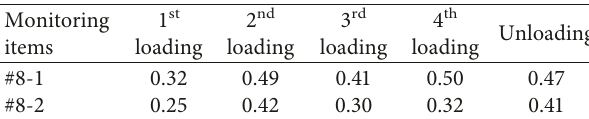
Table 4: Absolute height value of the pier top (unit: m). Monitoring